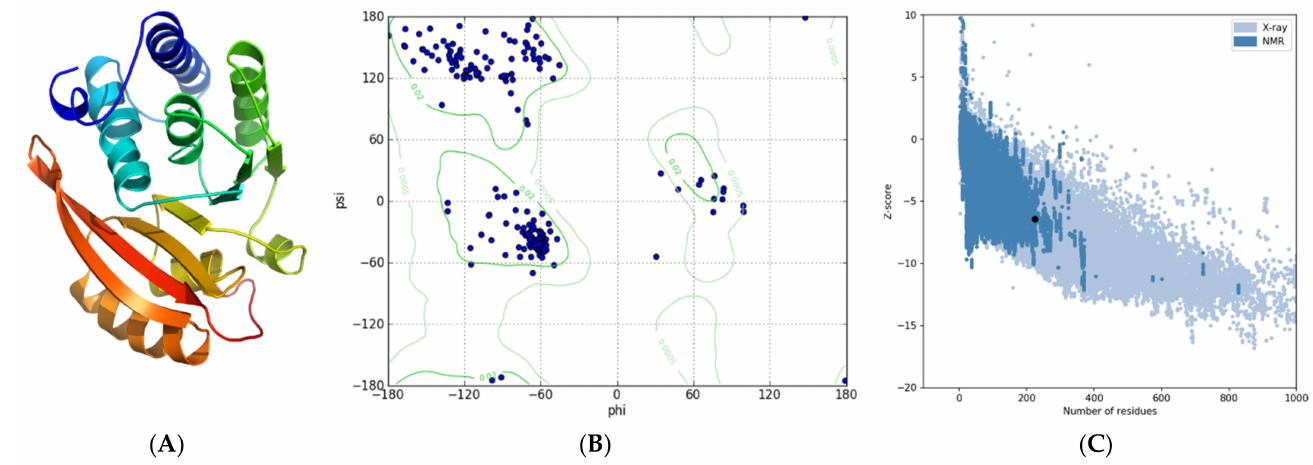
Figure 1. Predicted tertiary structure for Mt GidB. ( A ) Best 3D model (ribbon representation, rainbow-colored using default settings). ( B ) Ramachandran plot. ( C ) ProSA analysis (Z-score plot). A black dot denotes the estimated Z-Score.